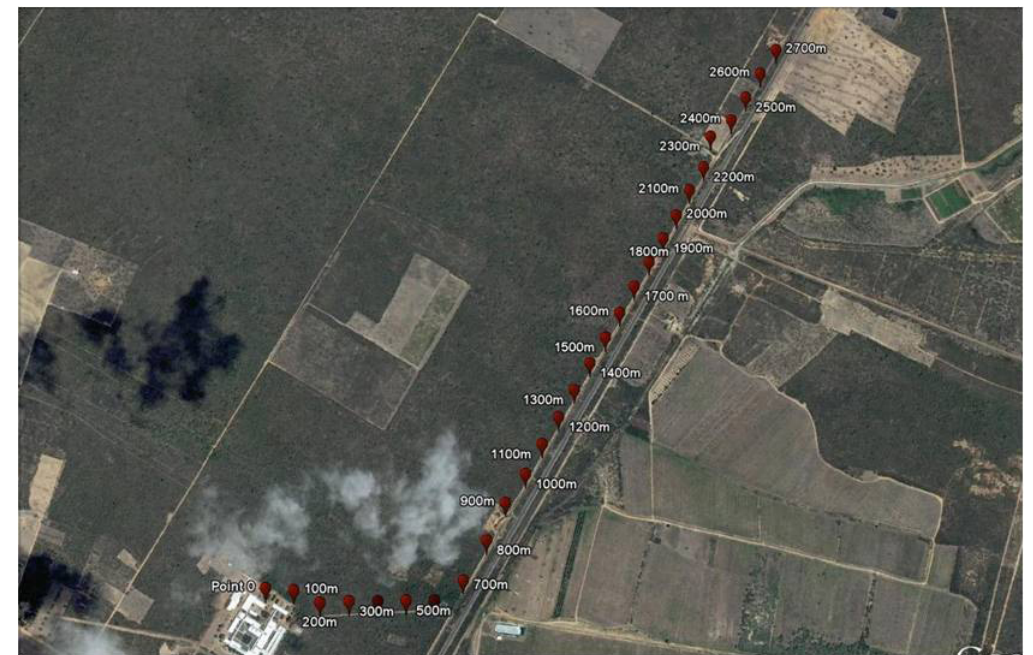
Fig 1. Geographical location of the distances where the Melipona mandacaia bees were released. Font: Laboratory of Geoprocessing, Embrapa